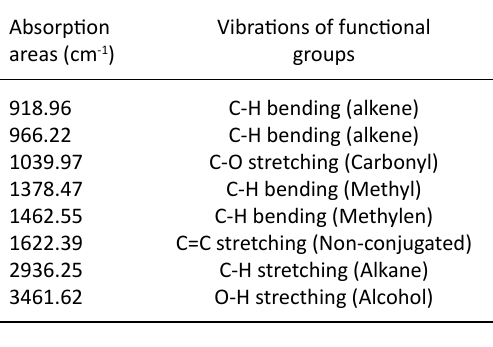
Table 6. FTIR absorption areas of the isolated compound of D8.3.5.7 fraction